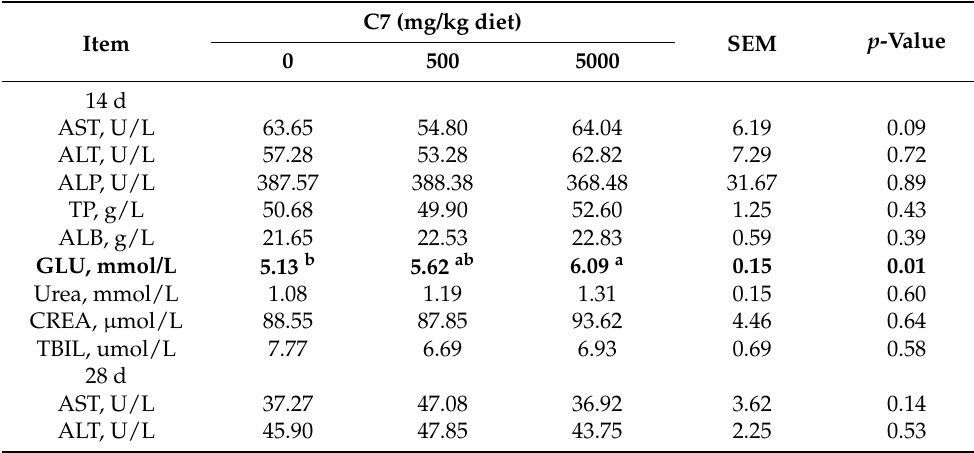
Table 10. Effect of high-dose C7 supplementation on serum biochemistry